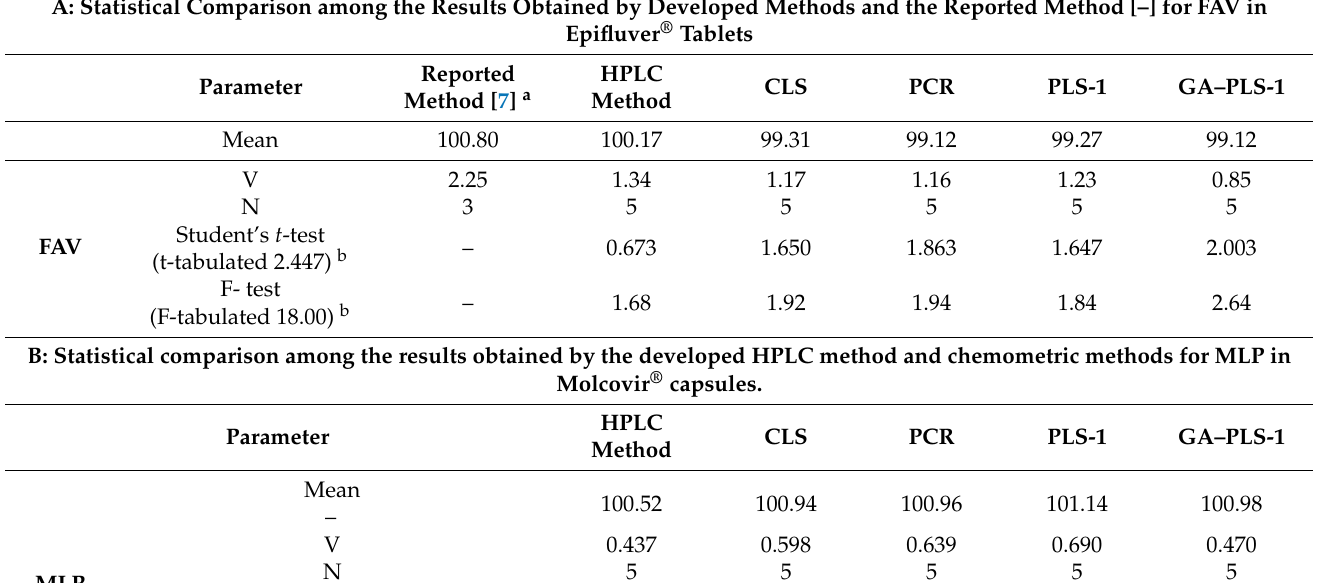
Table 7. Statistical comparison and application of the developed methods on the pharmaceutical